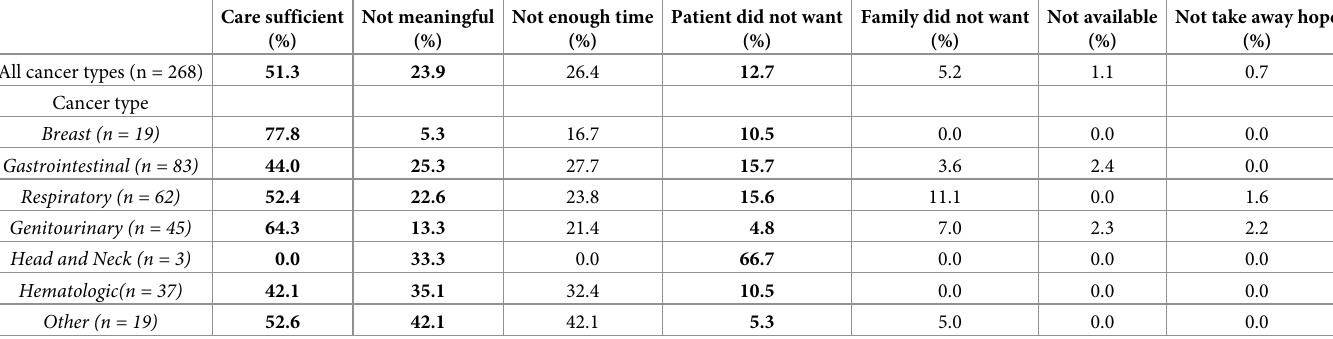
Table 4. Reasons given by physicians for not using specialist palliative care services (PCS) in patients who died of